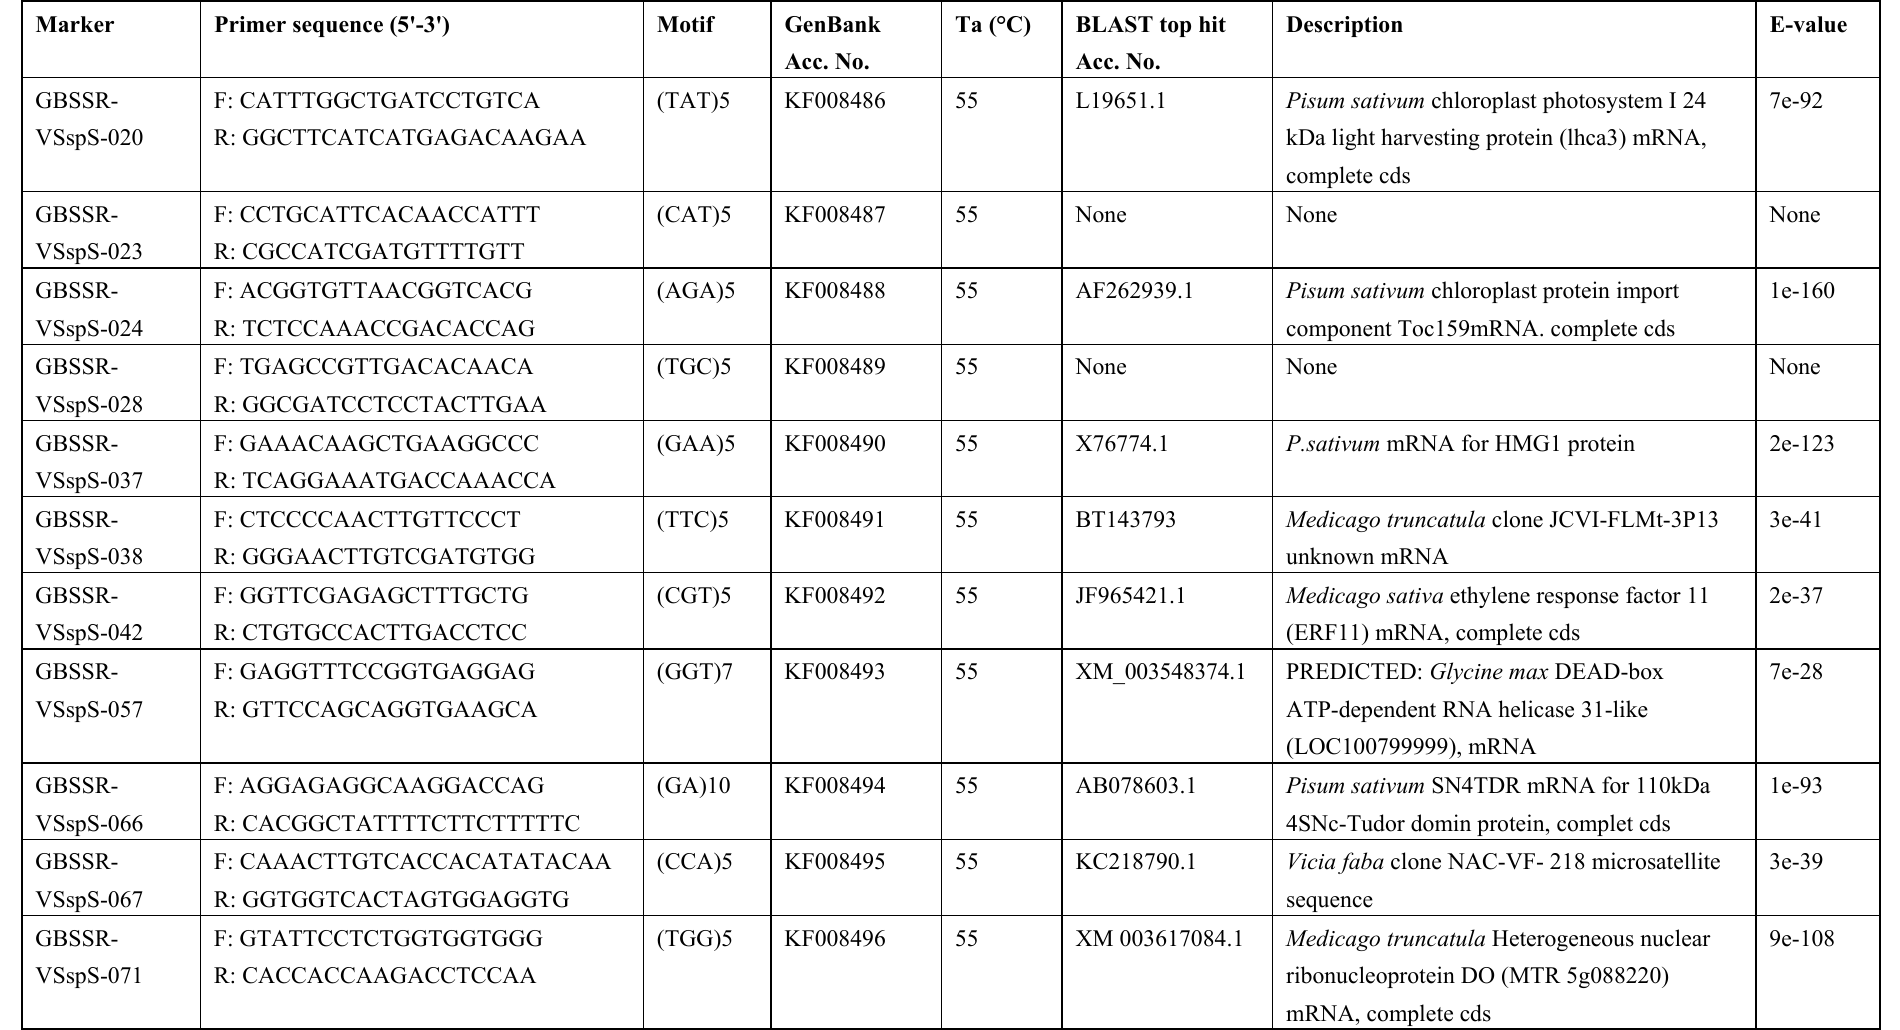
Table 1. Cha μ racteristics of the 65 cDNA-SSR markers for common vetch ( Vicia sativa subsp. sativa